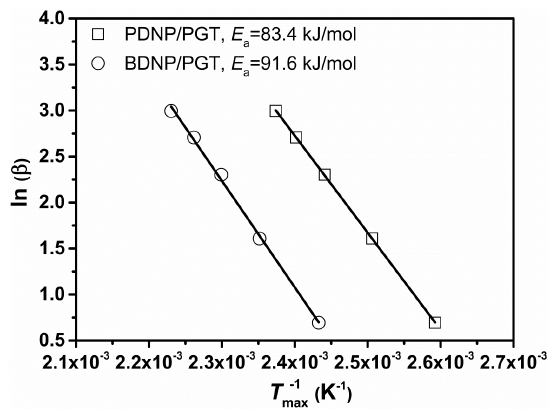
Figure 4. Dynamic DSC curves of PDNP ( n = 1)/PGT ( top ) and BDNP ( n = 2)/PGT ( bottom ) mixtures at different heating rates.